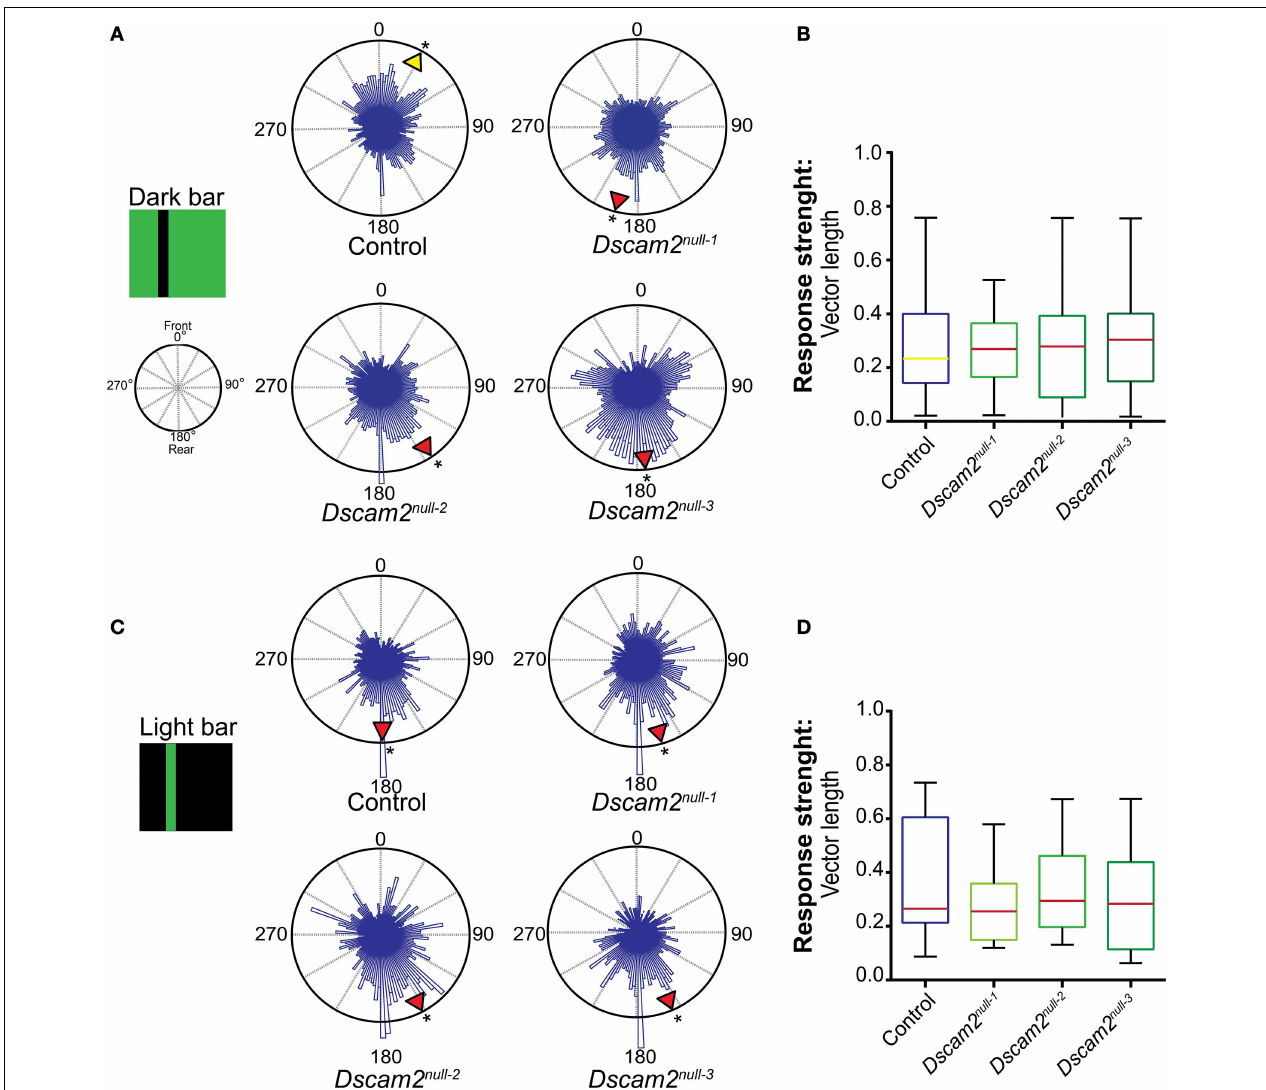
Dscam2 mutants demonstrate similar response strengths (indicated by median vector length) and variation for the fixation stimulus. The color of the median line corresponds with the color of the arrowhead (indicating direction) in (A) . (C) Control flies and Dscam2 mutant flies both place a light bar toward the back of the arena. (D) Control flies and Dscam2 mutants demonstrate similar response strengths (indicated by median vector length) and variation for the anti-fixation stimulus. As in (B) , the variation in strength of the response is visualized in boxplots with min to max whiskers. For all groups at least eight flies were run for every condition. A Kruskal-Wallis test indicated no significant difference between the vector lengths of the different fly